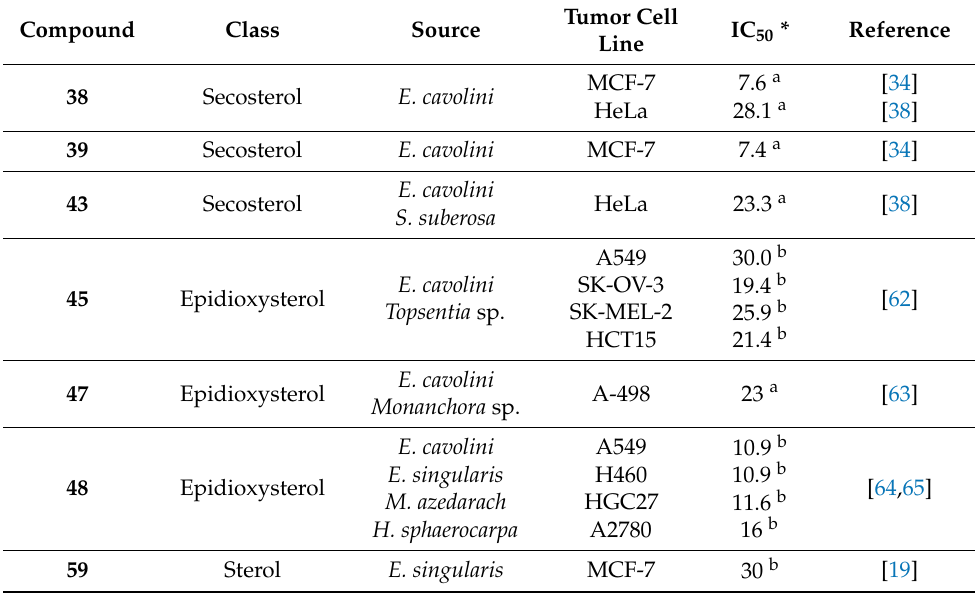
Table 2. The most promising sterols with remarkable cytotoxic activity isolated and studied from the genus Eunicella .